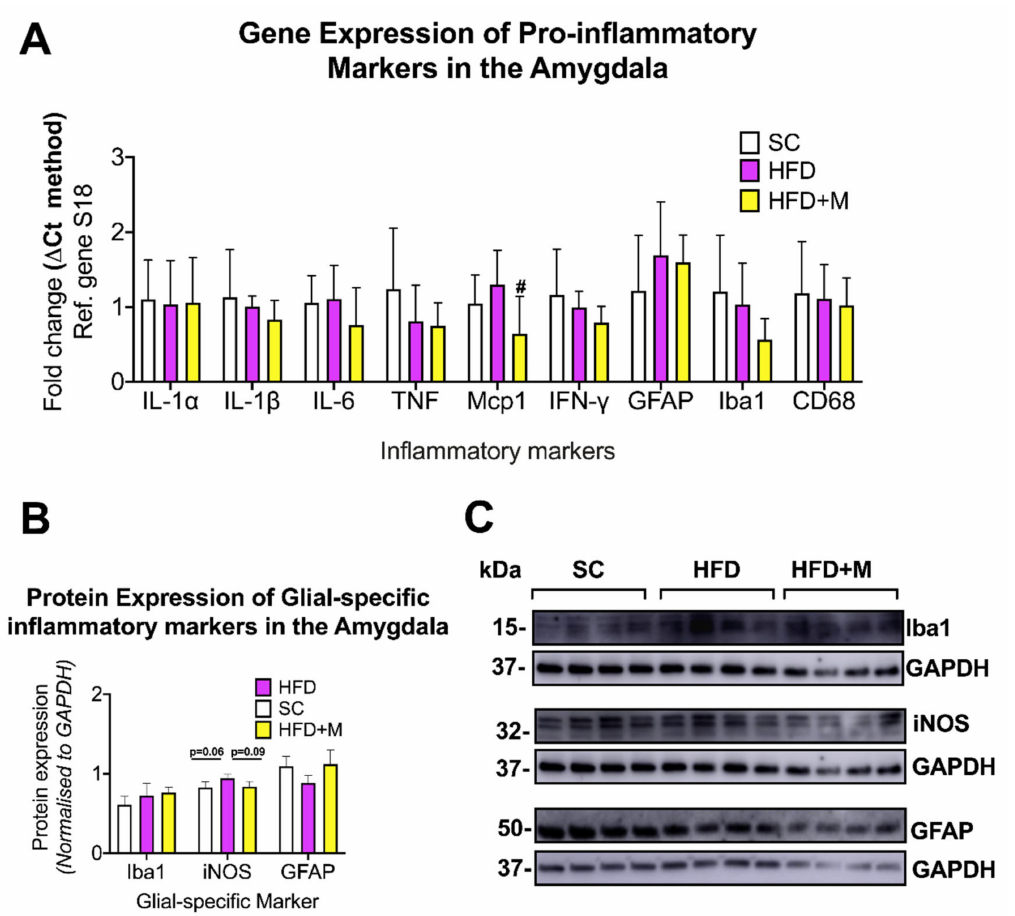
Figure 5. Gene and protein expression analysis of cytokines and glial-specific inflammatory markers in the amygdala of C57BL/6 mice in response to HFD or metformin administration. Mice were grouped as SC, HFD, and HFD + M. Amygdala were microdissected from the left and right sides of the brain from all treatment groups and were used for RNA and protein extraction with subsequent quantitative qPCR and Western blotting, respectively. ( A ) Differential gene expression levels of proinflammatory mediators and glial-specific inflammatory markers. ( B ) Protein expression levels of glial-specific inflammatory marker following normalization to the loading control, GAPDH. ( C ) Immunoblot bands for each marker. mRNA levels were quantified using the ∆ Ct method and normalized to the reference gene S18 (housekeeping gene). Data were presented as mean ± S.E.M. # p < 0.05 vs. HFD group as determined by one-way ANOVA followed by Tukey post-hoc test. n = 6–8 per group. Quantification of immunoblot bands was performed using the NIH ImageJ software. Data were given as mean ± S.E.M. P values were determined by one-way ANOVA followed by Tukey post-hoc test. n = 4 per